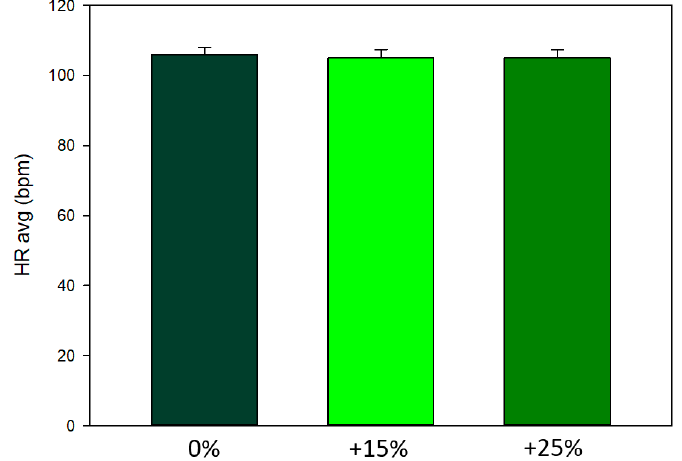
Figure 4. Average heart rates (mean ± se) of the 20 horses did not differ when ridden in a standard dressage test by their usual rider with no additional weight (0%: control), and with additional 15% and 25% of the rider’s bodyweight, in a balanced order across three test days.